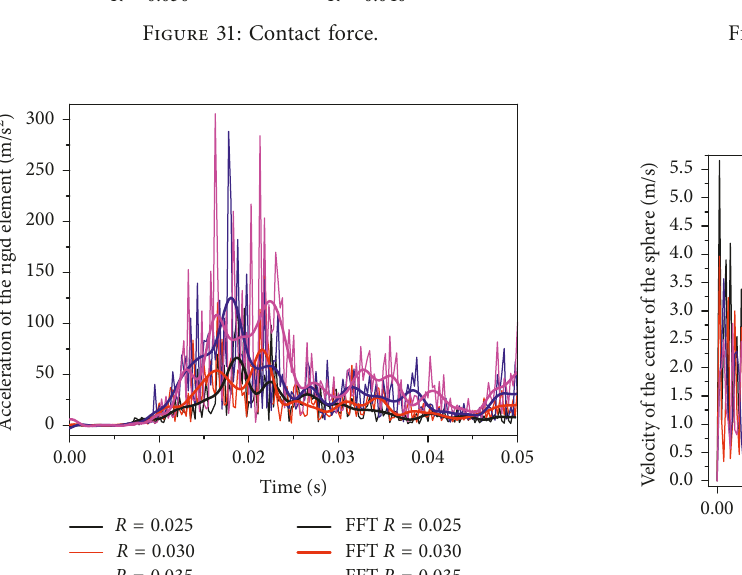
Figure 34: Acceleration of the sphere.